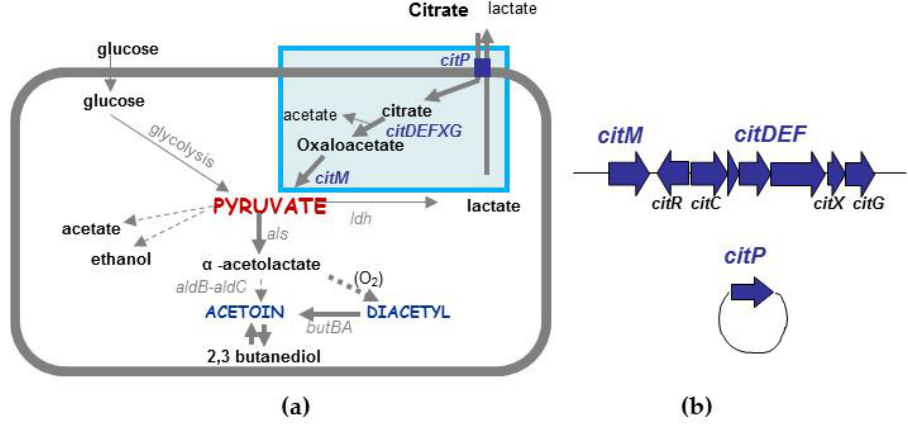
Figure 3. Main contributors to diacetyl/acetoin production. ( a ) pathways involved in citrate metabolism and aroma production. Pyruvate is a key intermediate. ( b ) chromosomal citrate operon and plasmidic citP gene involved in citrate transport.